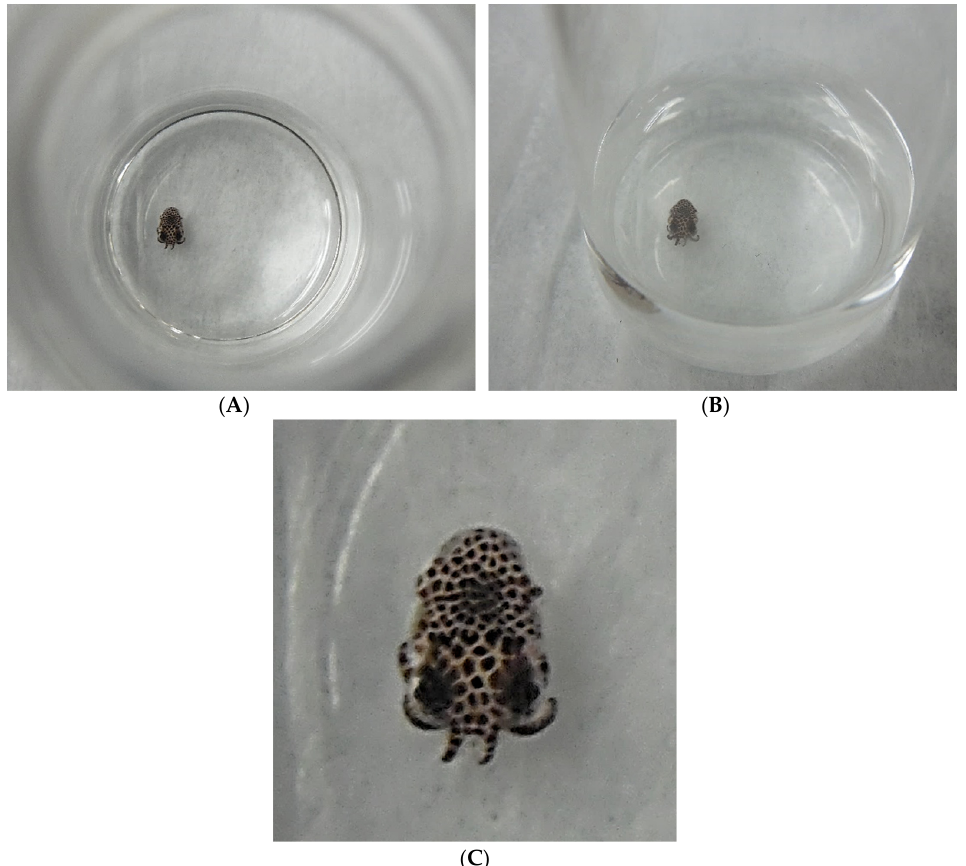
Figure 2. ( A ) (top view), ( B ) (oblique or slanted view), and ( C ) show a Euprymna squid hatchling a few hours after egg emergence. The hatchling is in a 10-mL scintillation vial with 5.0 mL 34 ppt artificial seawater (Instant Ocean). ( A , B ) are meant to provide scale as to the actual size of a typical “newborn” squid hatchling. The diameter of the 10-mL scintillation vial is nearly identical to an American 25-cent coin (25¢, a quarter, diameter = 24.3 mm). ( C ) is a close-up of the animal for easier viewing of the chromatophores. Pictures were taken with a HD Nikon L610 digital camera.